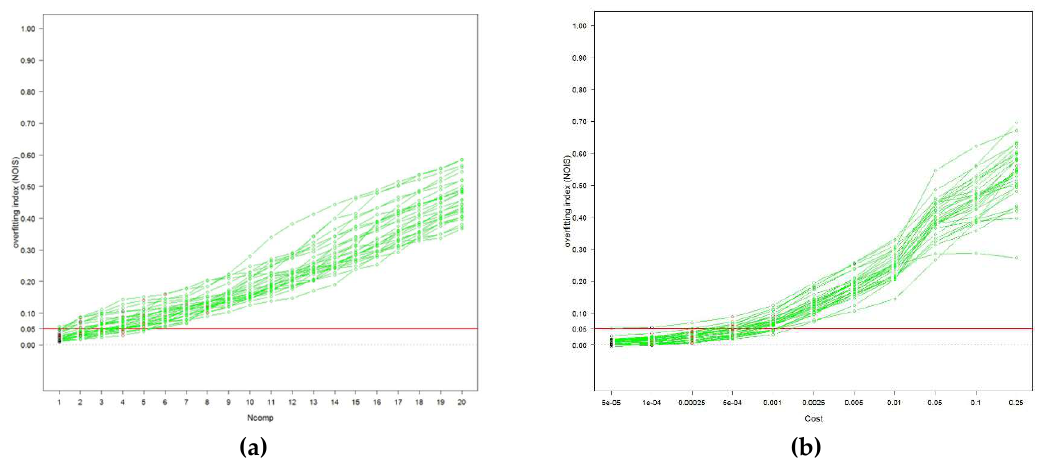
Figure A1. Results of the NOIS index for PLSR ( a ) and SVM ( b ) for the landscapes without spatial dependency (0%). Green lines show the naïve overfitting index (y-axis) develops with increasing model complexity (x-axis) for each realisation. The red and black circles are the model complexity selected by the tuning process using a cross-validation approach from the original and naïve data respectively. The red line is a threshold, and the model complexity selected is set at the highest level the naïve overfitting index remains under. The script to run the NOIS method in R and the data based used in this paper is publicly accessible at DOI: 10.4121/uuid:2016d562-cf6e-4060-ac13-5db9477b6512